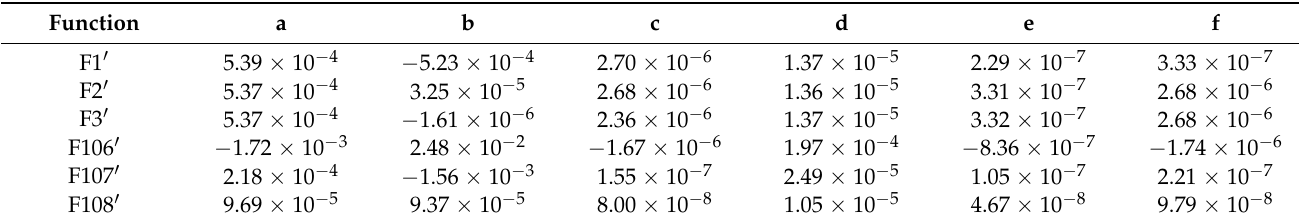
Table 5. Output linear function parameters values from Princ1 fuzzy system fitted by ANFIS.